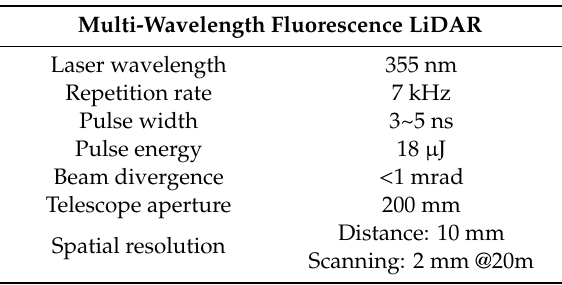
Table 1. Technical parameters of MWFL system design.